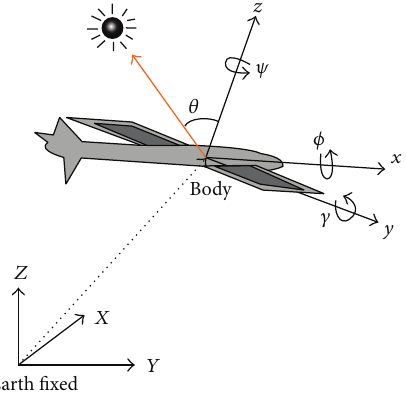
Figure 1: Cartesian coordinate system